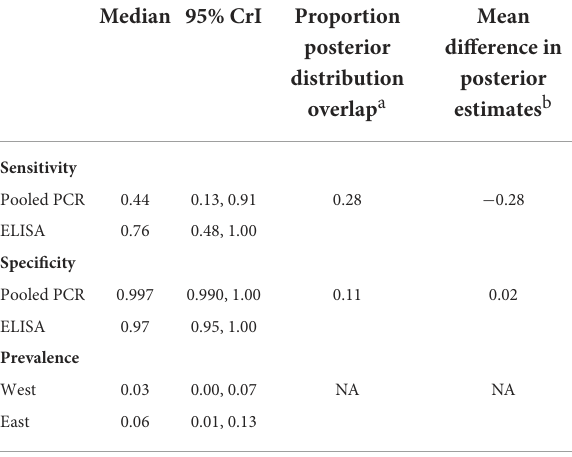
TABLE 6 Sensitivity and specificity estimates for MAP diagnosis in 913 beef cows in the absence of a gold standard using a three-test, two population Bayesian latent class model with non-informative priors and using a subset of the data including only cows for which all three diagnostic tests were completed.